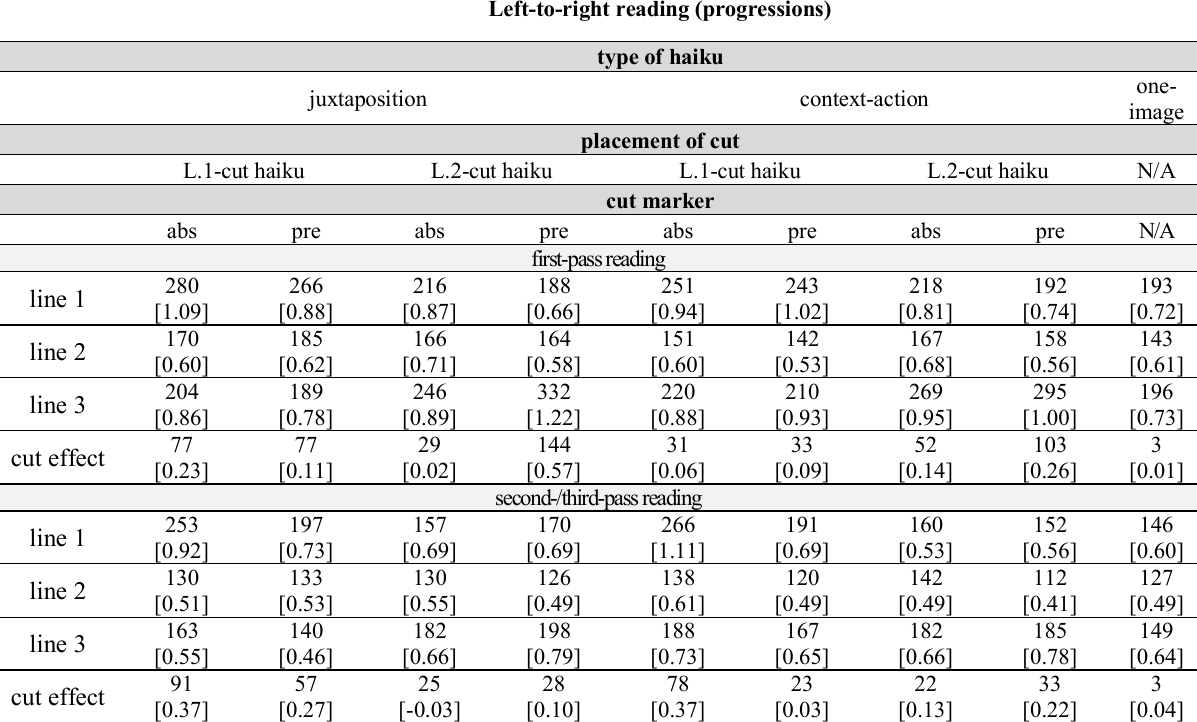
Table 2 . Fixational dwell times (per word) following progressive saccades during first-pass (top-half) and second-pass (bottom-half) reading in milliseconds (number of fixations given in parentheses). Dwell times are normalized per word to correct for differential line lengths in terms of word number among the three poem lines. The extended time spent on the fragment line (line 1 in L.1-cut and line 3 in L.2-cut haiku) relative to the [remote] phrase line (line 3 in L.1-cut and line 1 in L.2-cut haiku) represents the cut